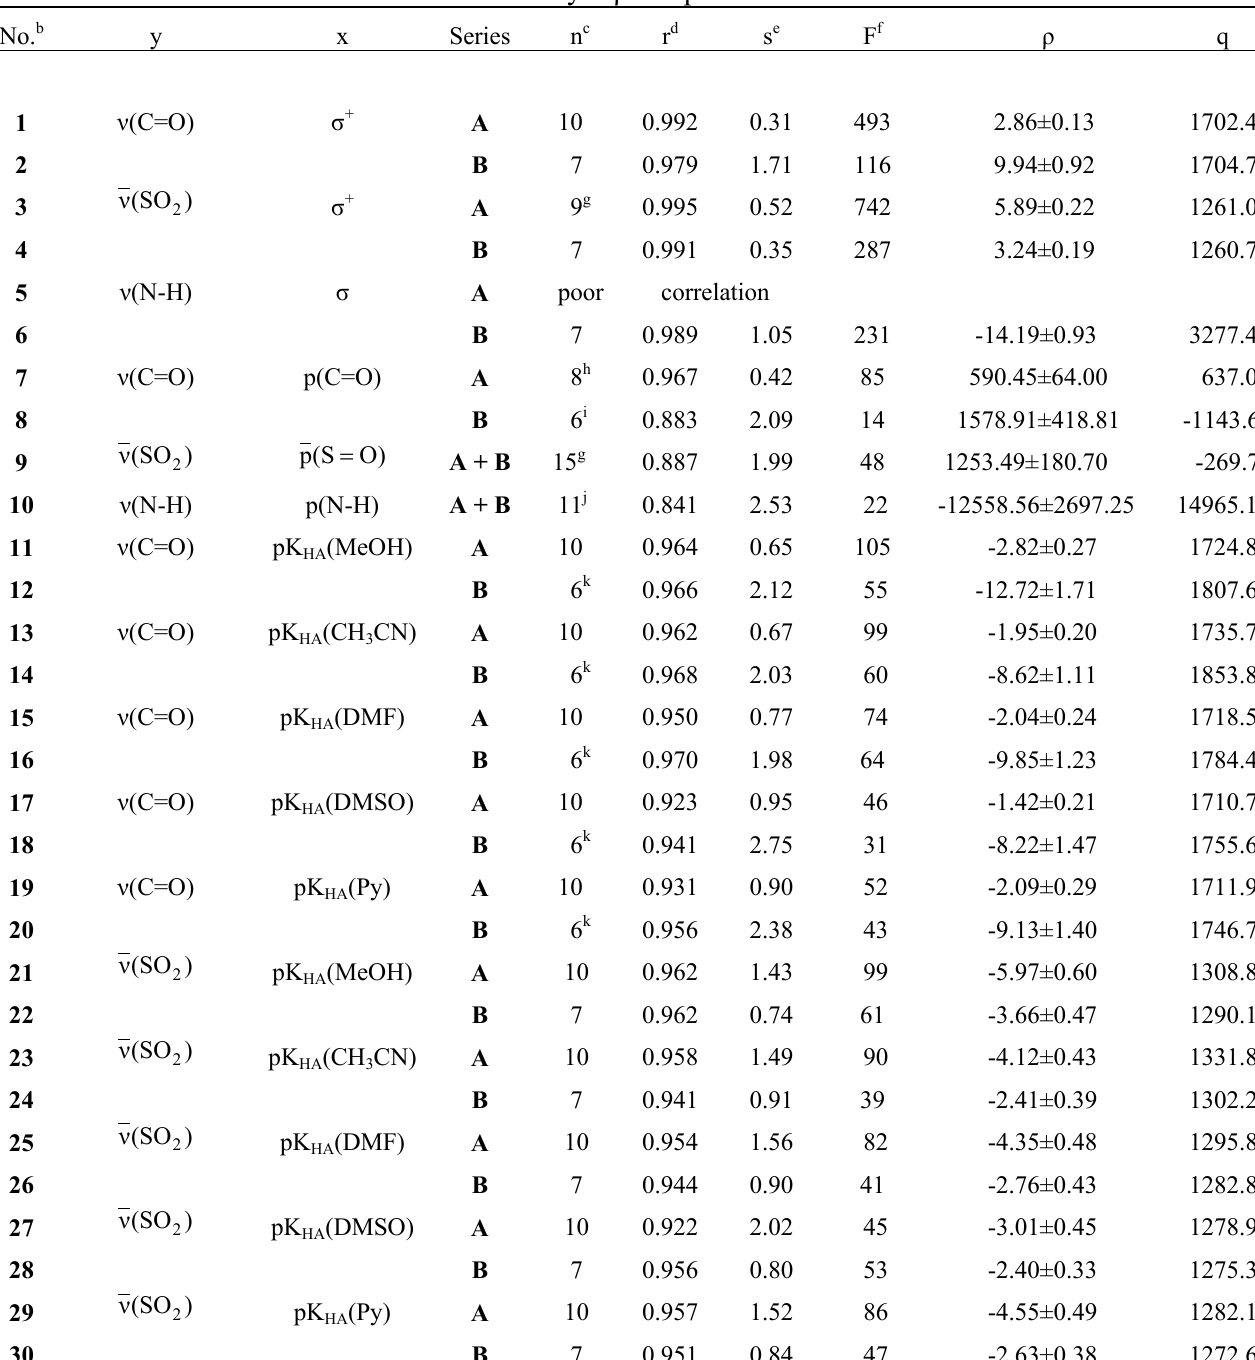
Table 4. Mono parameter correlations of IR spectral data a , substituent constants, dissociation constants and theoretical parameters for substituted N